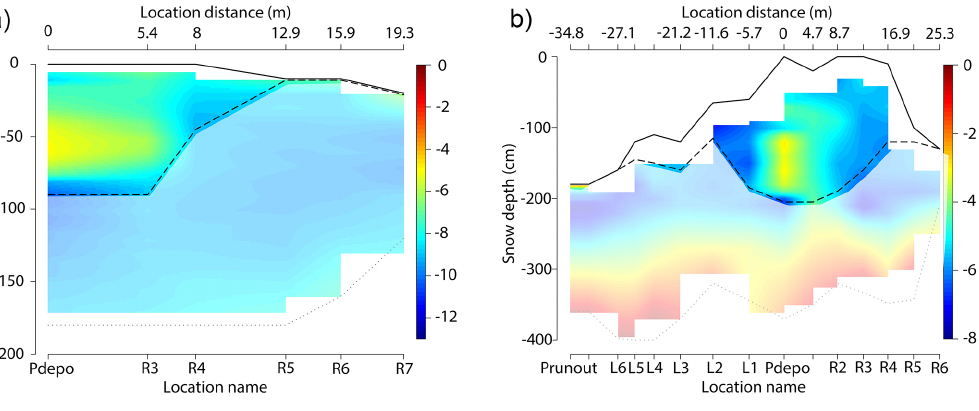
Figure 8. Lateral snow temperature profiles in the avalanche deposits of (a) avalanche #2 and (b) avalanche #3. P depo and 0m indicate the centre of deposits and the index “L” and “R” represent left and right, looking uphill, measurement locations towards the lateral sides of the avalanches. Lines indicate the top of the avalanche deposit or snow cover (solid), bottom of avalanche deposit (dashed) and bottom of snow cover (pointed). Colours of undisturbed snow cover were softened for better distinction with avalanche deposits.